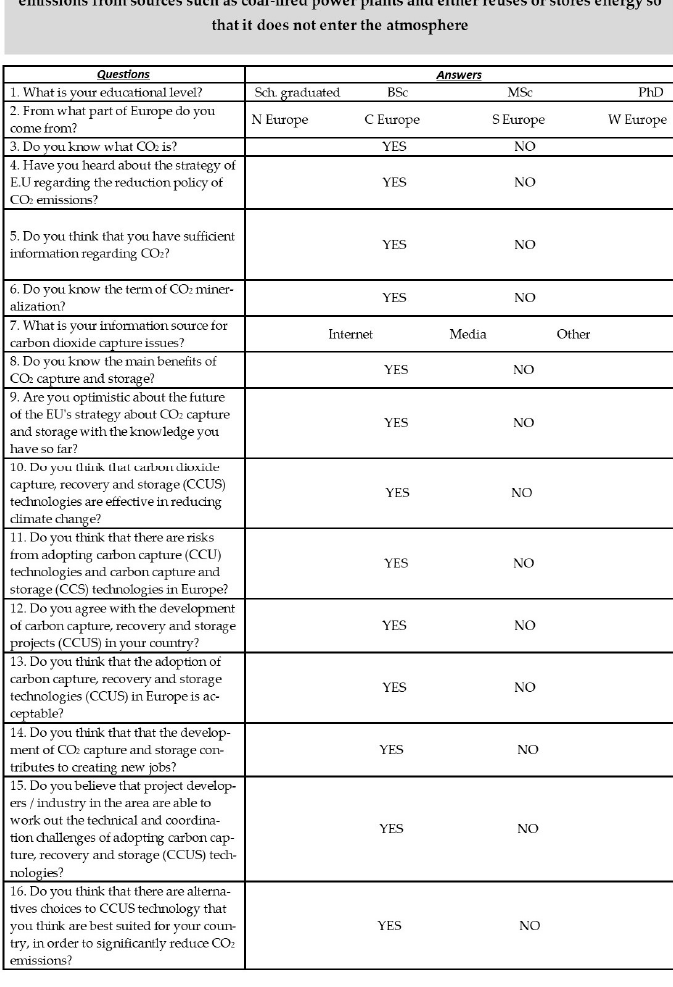
Figure 5. Questionnaire shared and completed by European citizens.